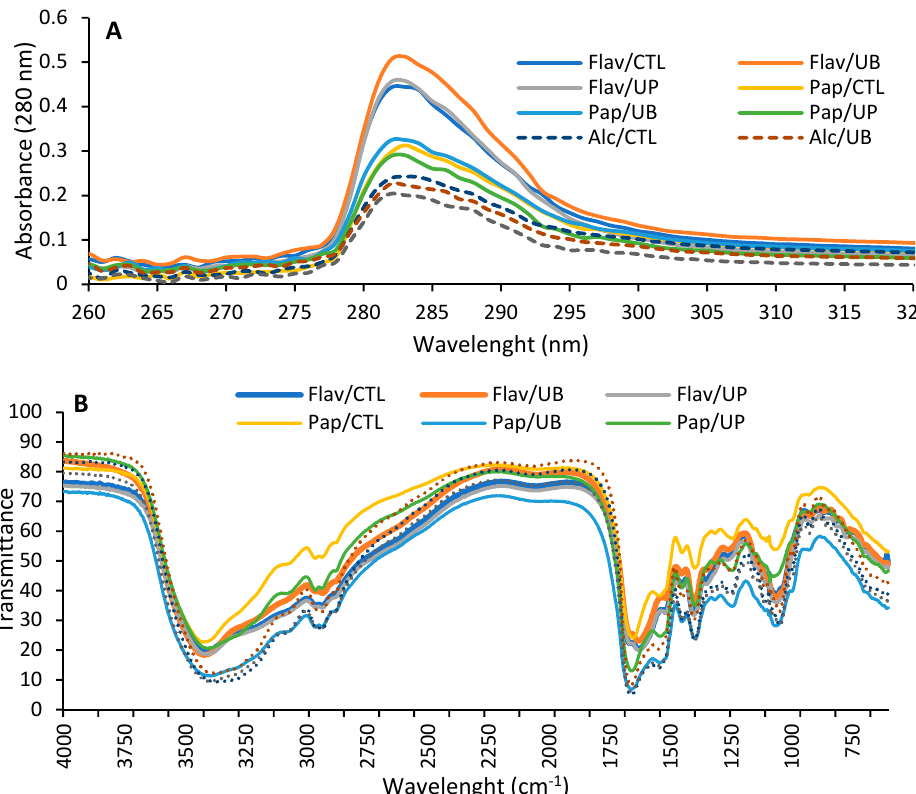
Figure 2. Spectroscopic spectra of hydrolysates from proteins extracted in control (CTL), ultrasonic bath (UB), or ultrasonic probe (UP) conditions. ( A ) UV spectra from 260 to 320 nm; ( B ) FT-IR recorded between 600 and 4000 cm − 1 . Proteins were hydrolyzed with Flavourzyme (Flav), papain (Pap), or alcalase (Alc).